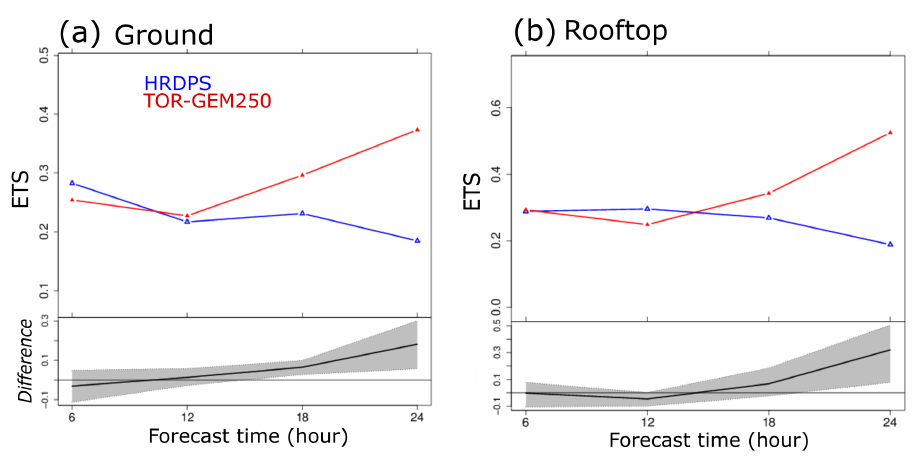
Figure 17. Equitable Threat Score (ETS) for the category of precipitation accumulation exceeding 5 mm during periods of 6 consecutive hours, for ( a ) the ground stations and ( b ) the rooftop stations. The closer that ETS is to 1, the better the precipitation